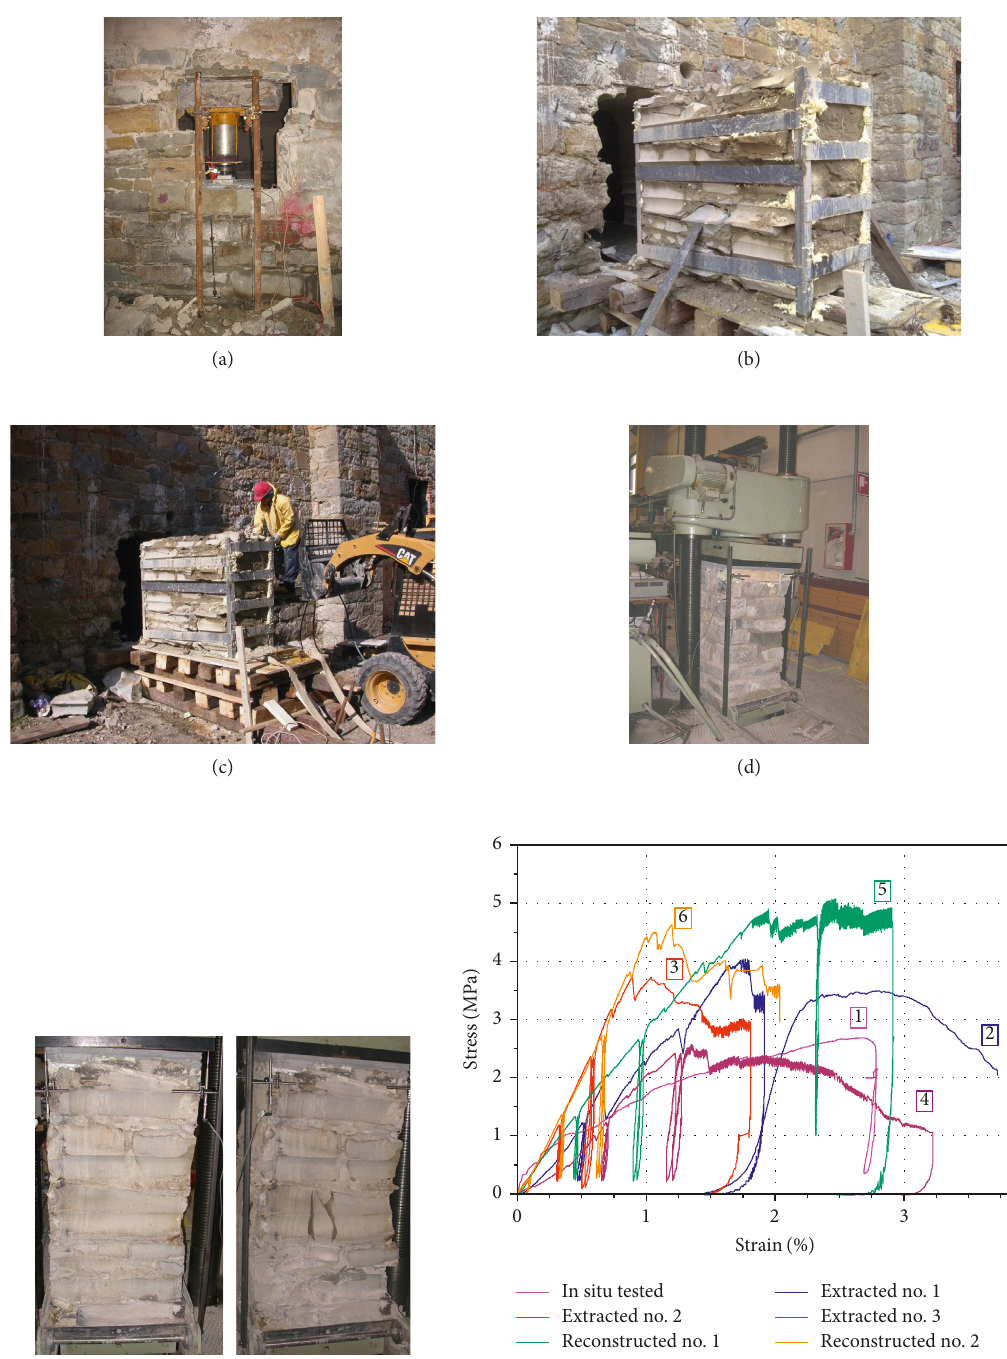
Figure 4: Compression tests on stonework specimens: (a) experimental setup for in situ compression test on specimen no. 1; (b) extraction of wall specimens; (c) transportation to the laboratory for testing; (d) experimental setup for laboratory compression test; (e) specimen no. 4 before (left) and after (right) compression test; (f) experimental stress-strain curves obtained from the in situ tests and laboratory tests on extracted and reconstructed